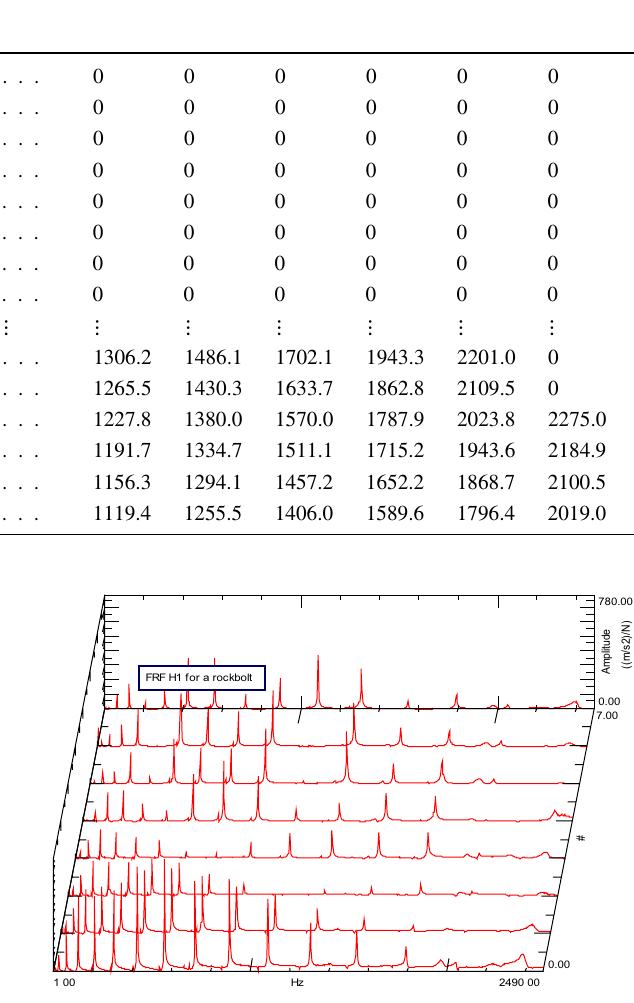
Table 1 The example of calculated natural frequencies of the finite element models of investigated rock bolts Lack of gout from a plate.